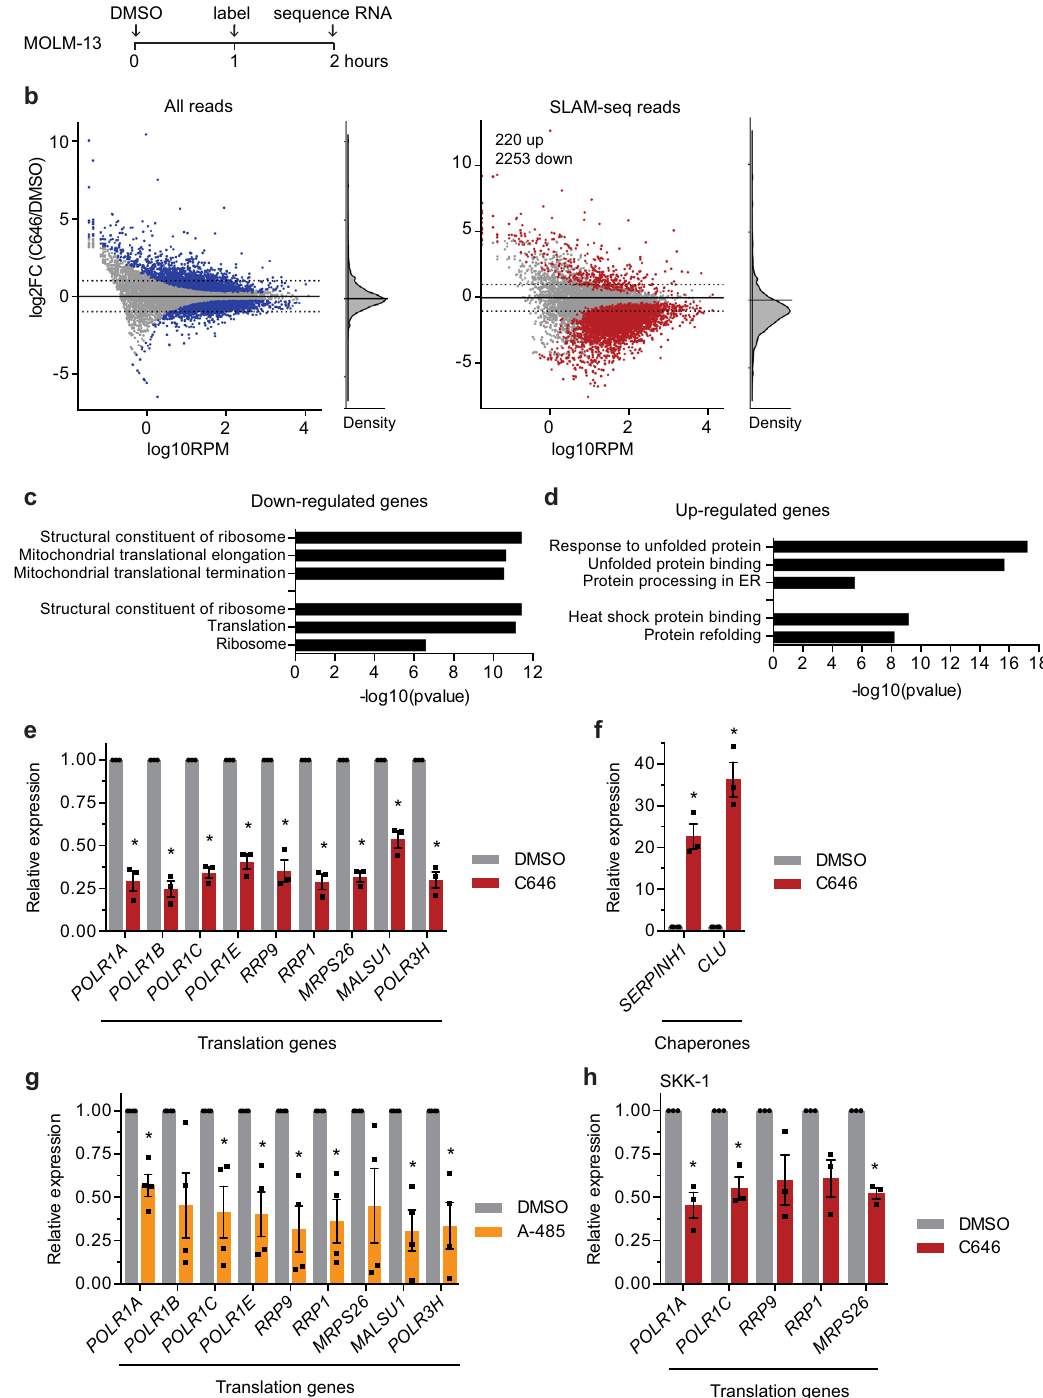
Fig. 3 Immediate target genes of CBP/p300 identi fi ed by SLAM-seq. a Schematic work fl ow of the SLAM-seq sample preparation protocol for the metabolic labelling of newly synthesized RNAs. MOLM-13 cells were treated with 10 µ M C646 or DMSO, labelled with 4sU after 1 h, the RNA was